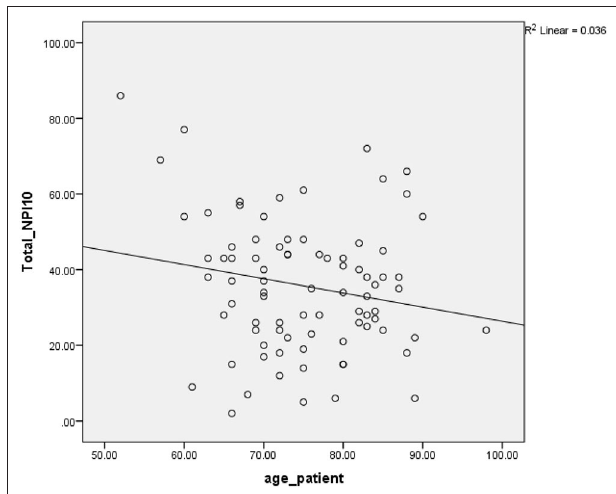
FIGURE 1 | The relationship between age and NPS.